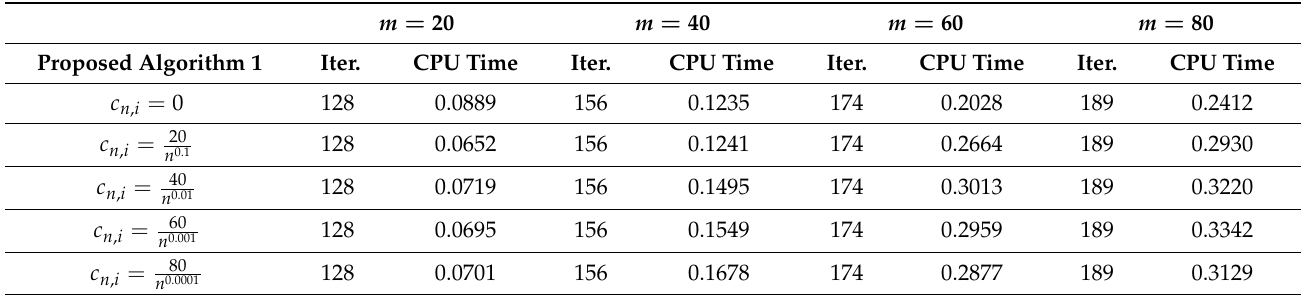
Table 1. Numerical results for Experiment